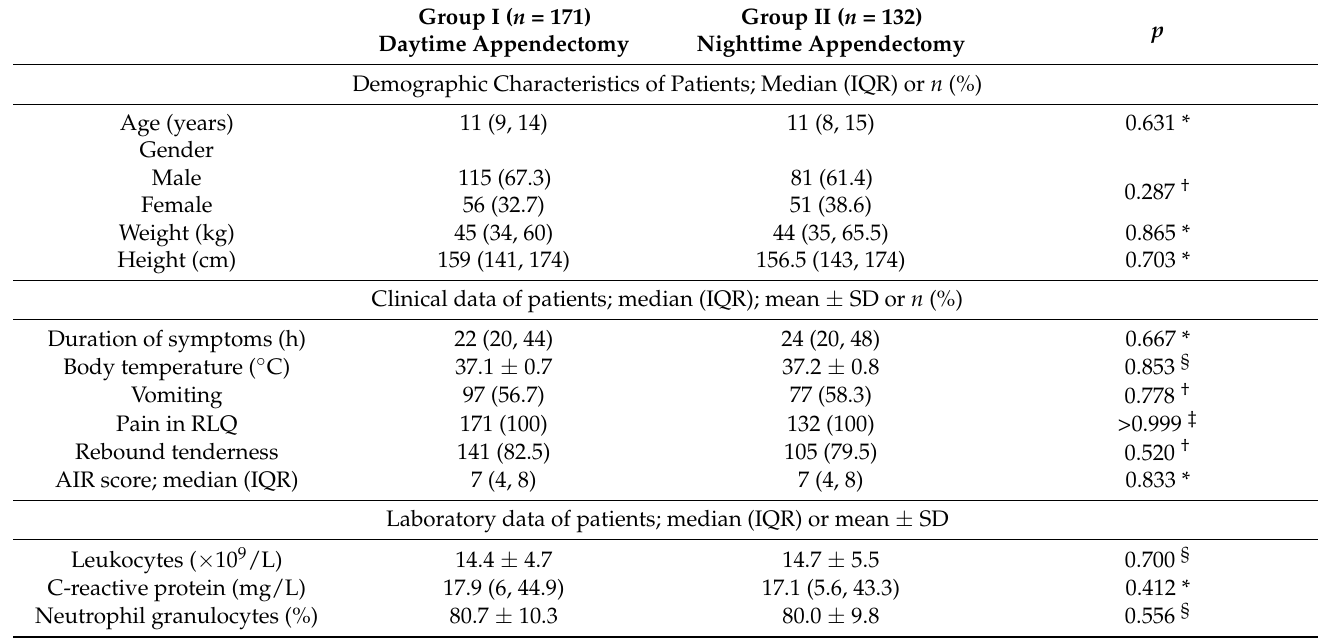
Table 1. Demographic characteristics, clinical and laboratory data of patients.